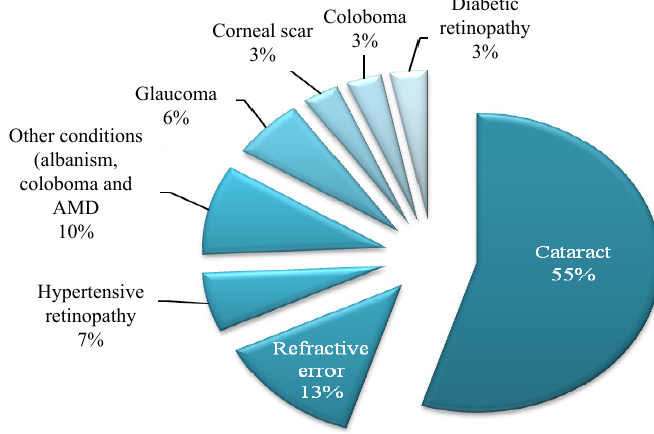
Figure 2 : Causes of